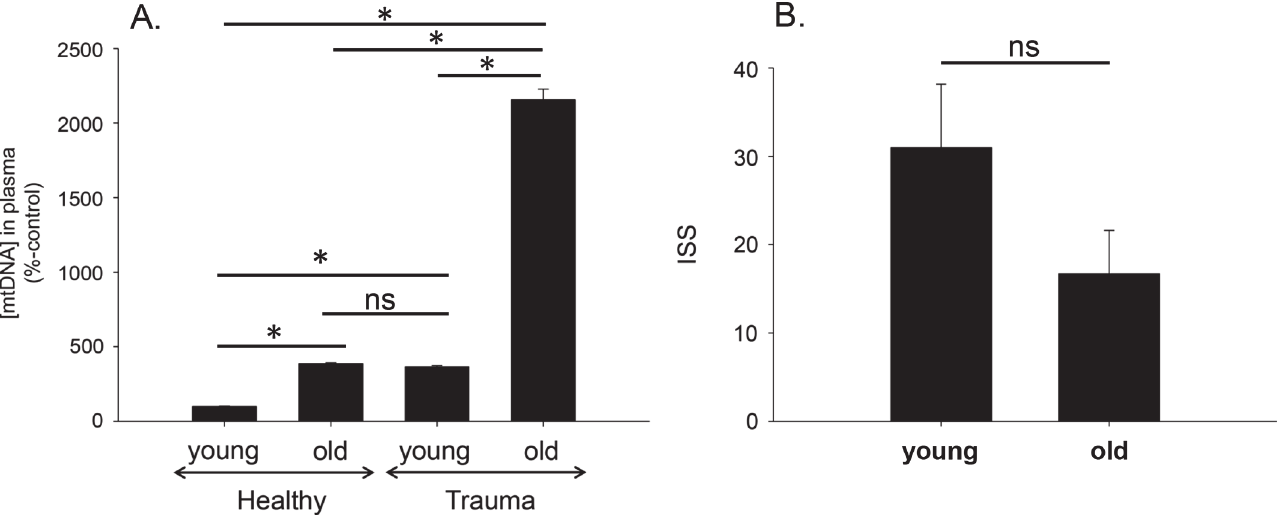
Fig 4. Plasma mtDNA levels are higher in the elderly. A . MtDNA concentration was assessed in plasma obtained from subjects from four groups: 1. Young healthy (n = 11, average age 23 years); 2. Elderly healthy (n = 7, average age 72 years); 3. Young trauma (n = 9, average age 37 years); and 4. Elderly trauma (n = 6, average age 83 years). All pairs showed significant difference except between old healthy vs. young trauma; p < 0.001, One Way ANOVA, followed by Tukey ’ s Test. B . ISS is shown for young and older trauma patients listed in A . p = 0.164 (Student ’ s